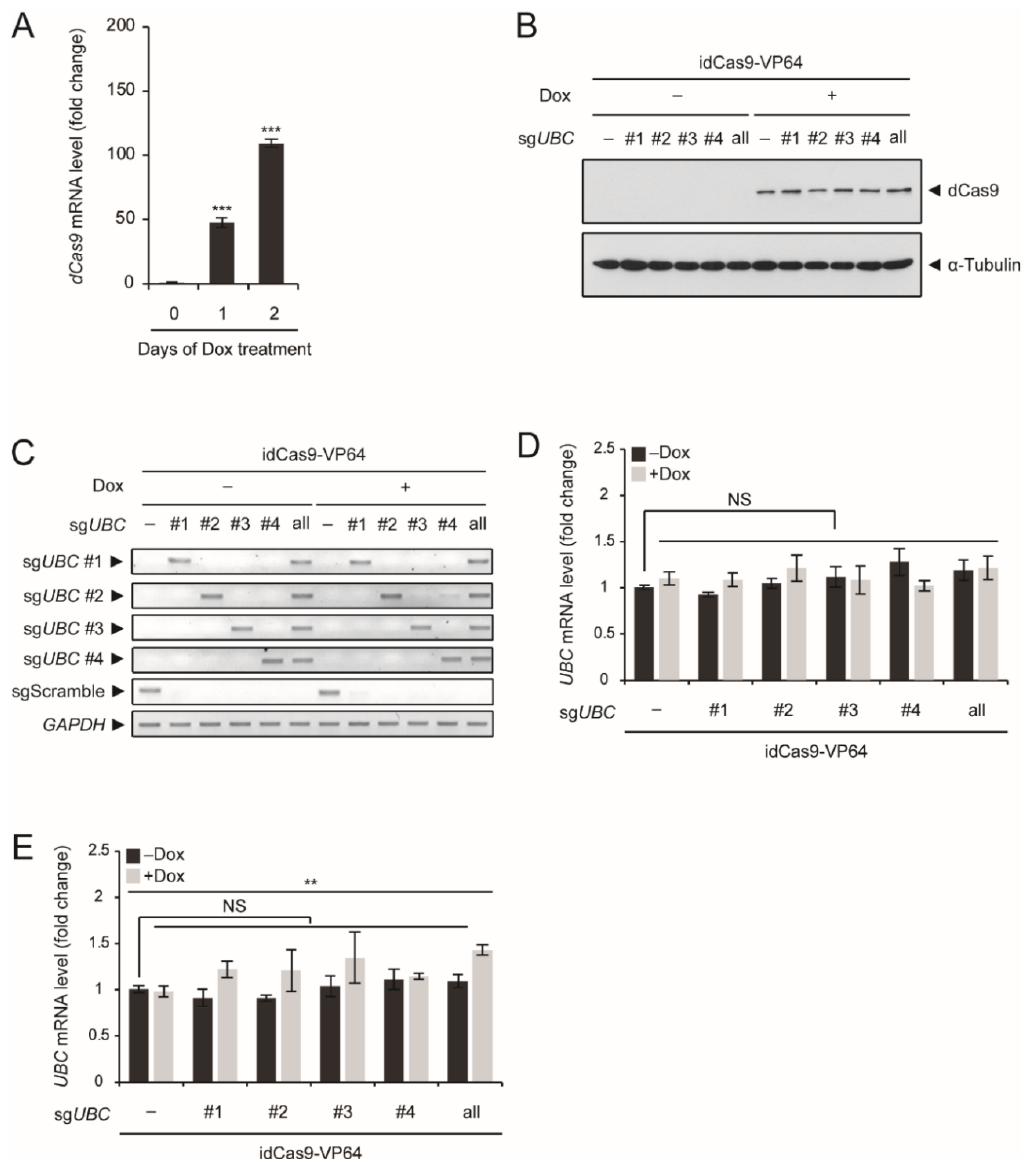
Figure 2. Evaluation of UBC upregulation using the idCas9–VP64 system with sgRNAs targeting the UBC intron. ( A ) HEK293T cells were transiently transfected with idCas9–VP64 and scrambled sgRNA and then treated with 5 µ g / mL Dox for up to 2 days. dCas9 mRNA levels were determined by qRT-PCR ( n = 3 each), normalized to GAPDH , and expressed as the fold change relative to the control (0 days of Dox treatment). ( B ) HEK293T cells were transiently transfected with idCas9–VP64, and scrambed sgRNA (indicated as -) or sg UBC #1~#4, alone or in combination, and then treated with 5 µ g / mL Dox for 2 days. dCas9–VP64 was detected by immunoblot analysis using an anti-Cas9 antibody. α -Tubulin was used as a loading control. ( C ) Expression of scrambled sgRNA (sgScramble) or sg UBC #1~#4 was determined by conventional RT-PCR. GAPDH was used as an internal control. ( D , E ) Transient transfection of HEK293T cells and Dox treatment were performed as described in ( B ). In ( E ), HEK293T cells were treated with 10 µ g / mL Dox for 2 days. UBC mRNA levels were determined by qRT-PCR ( n = 3 each), normalized to GAPDH , and expressed as the fold change relative to the control (-Dox, scrambled sgRNA). Representative immunoblots and RT-PCR results are shown from three independent experiments ( B , C ). Data are presented as means ± SEM from the indicated number of samples ( A , D , E ). ** p < 0.01; *** p < 0.001 vs. control (0 days of Dox treatment) or between two groups as indicated by horizontal bars. NS: Not significant.